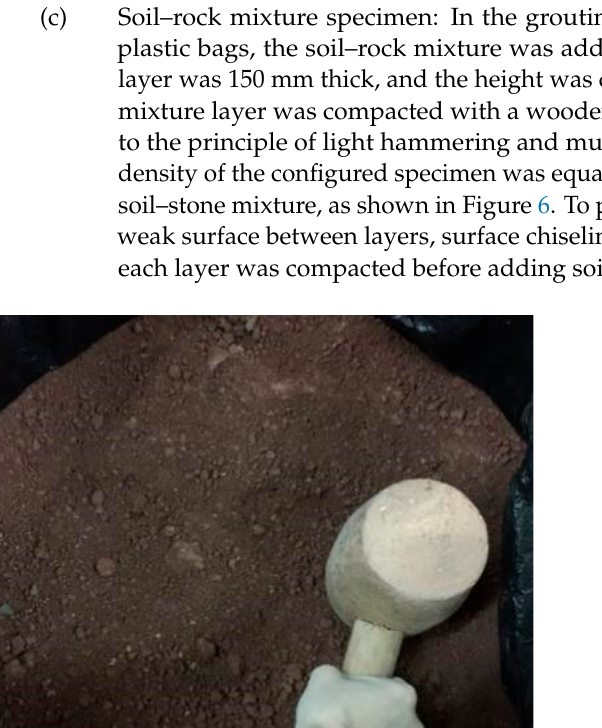
Figure 5. Control water content.